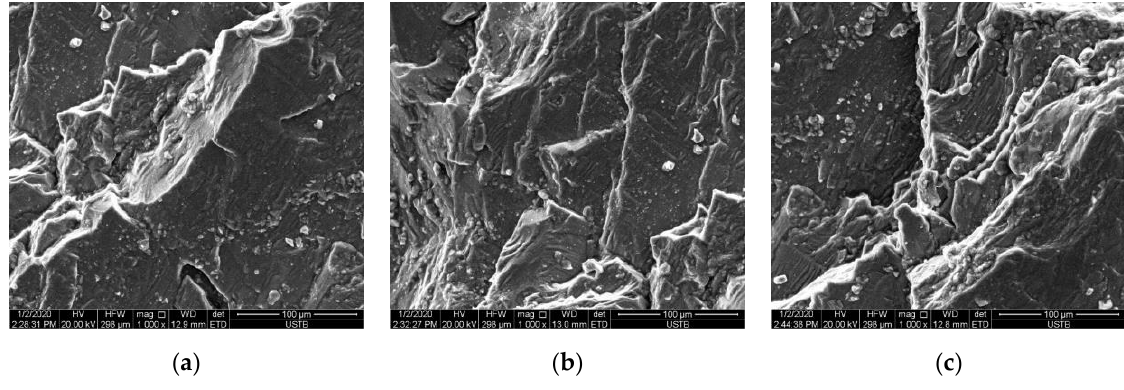
Figure 3. SEM scanning image. ( a ) A1, ( b ) B1, ( c ) C1.